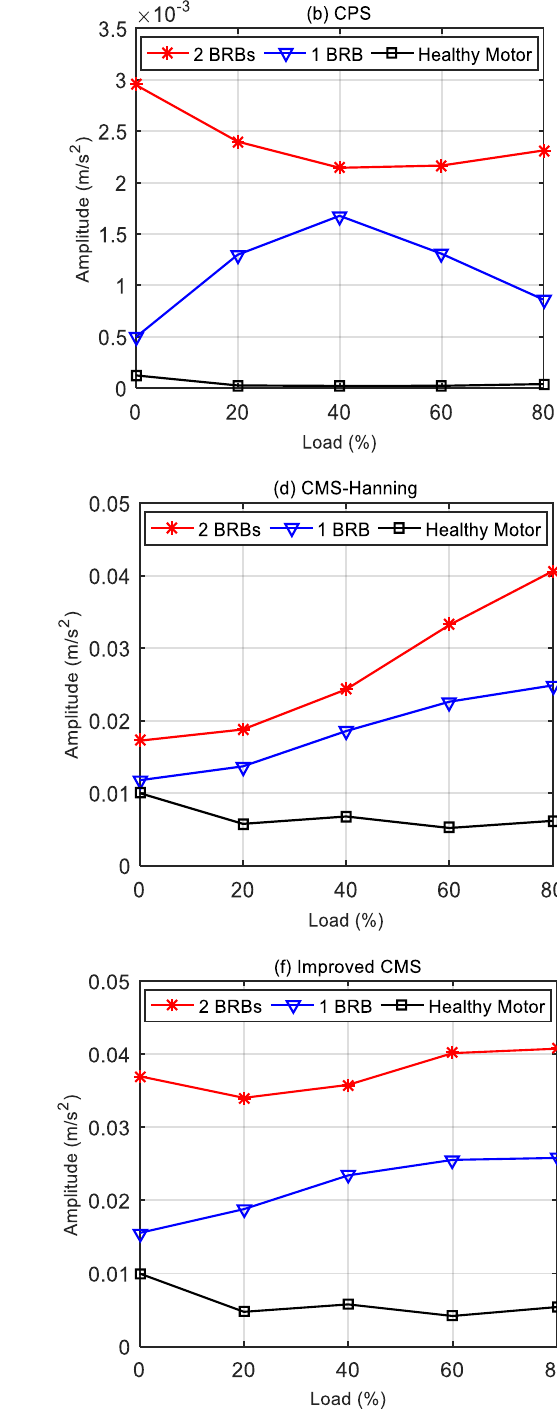
Figure 11. The amplitudes of characteristic frequency component α 0 under different loads in three BRB cases extracted by ( a ) PSD, ( b ) CPS, ( c ) fast spectral correlation (FSC), ( d ) CMS with Hanning window function, ( e ) CMS with window length of 2 7 and step size of 30% of the window length, and ( f ) the improved CMS, respectively.